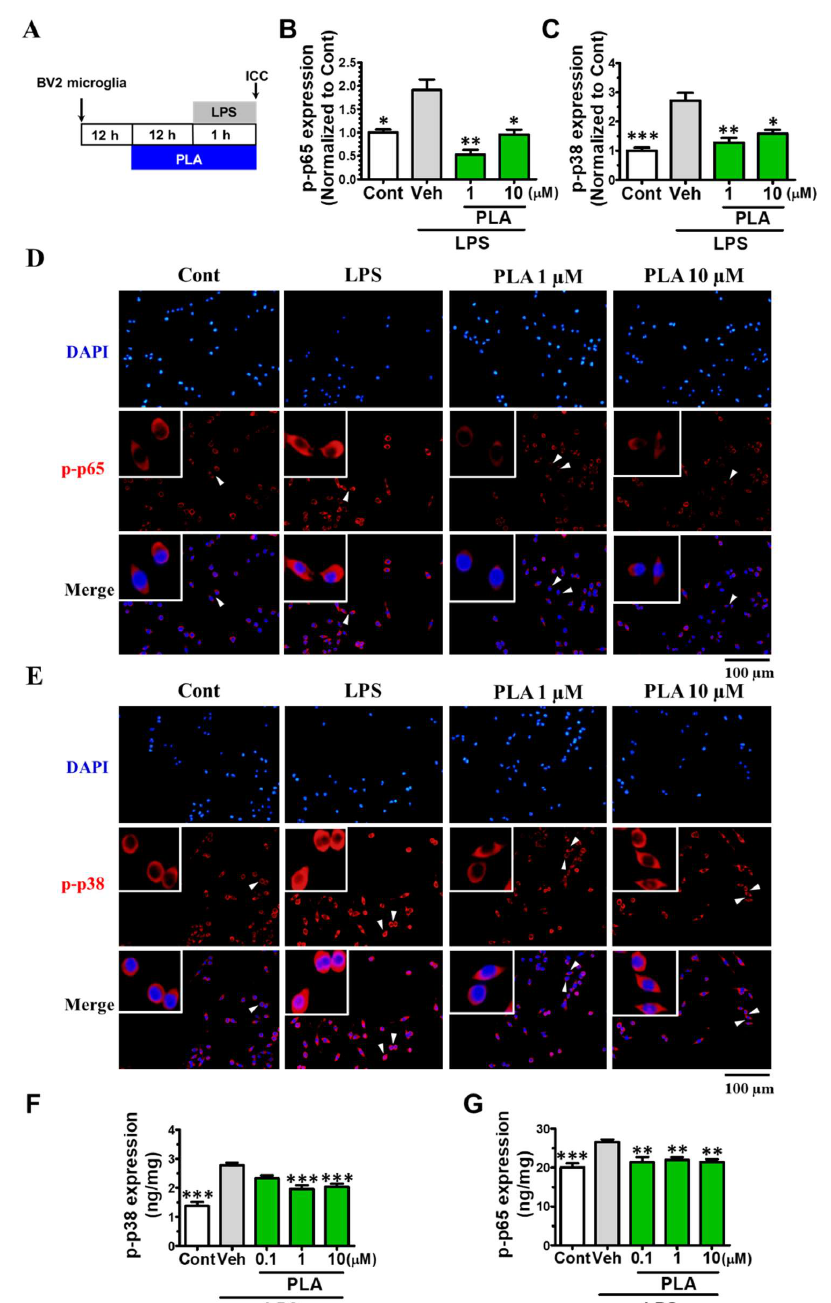
Figure 4. Effects of platycodigenin (PLA) on LPS-induced phosphorylation of NF-κB p65 and MAPK p38. BV2 microglia were cultured for 12 h and pretreated with PLA (1 and 10 μM) or control (Cont, 0.1% DMSO) for another 12 h, followed by stimulation with LPS (100 ng/mL) for 1 h. The cells were fixed and immunostained for p -p65 and p -p38. The fluorescent intensity was measured. ( A ) Experimental schedule. Phosphorylation of p65 ( B ) and p38 ( C ) per cell were quantified. The representative images of p -p65 ( D ) and p -p38 ( E ) were showed. ( F,G ) Phosphorylation of p65 and p38 per mg total protein were quantified by ELISA kit. The data are normalized to the control and shown as the mean ± SEM of three independent experiments. Ten images were captured (B-E) and four replicates (F-G) were performed of each group in the independent experiment. * p < 0.05, ** p < 0.01, and *** p < 0.001 versus vehicle (Veh), Kruskal-Wallis one-way analysis of variance by ranks test and one-way analysis of variance and Dunnett’s post hoc